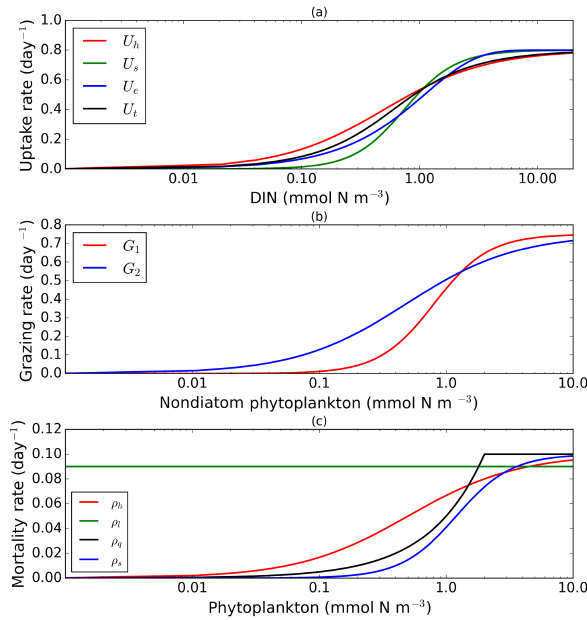
Figure 1. Nearly identical curves which describe resource up- take (a) , zooplankton grazing (b) , and phytoplankton mortality (c) . Panel (a) shows four uptake functions, which have been optimized to the default uptake function, Monod ( U h ). Panel (b) shows two grazing functional forms, the Holling type III ( G 1 ) and type II ( G 2 ) functions. Four phytoplankton mortality functions are shown in (c) , whereby hyperbolic is the default function. The optimiza- tion method is described in Sect. 2.1, 2.2, and 2.3. The range for DIN in (a) is between 0.001 and 20mmolm − 3 , and phytoplankton in (b) and (c) are 0.001 and 10mmolm − 3 . Table 1 describes the function’s equations and